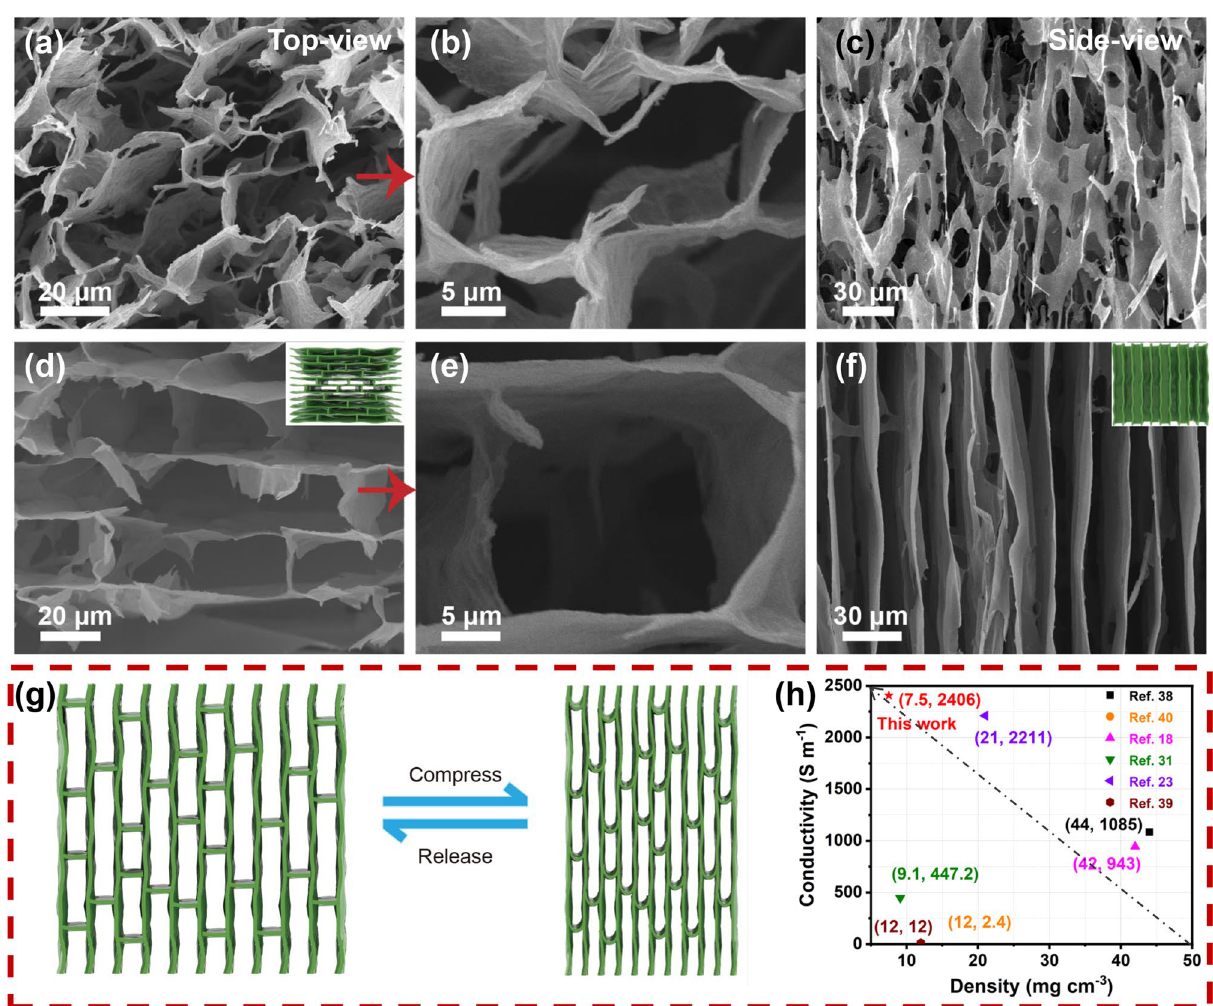
Fig. 2 a , b The top-view and c side-view SEM images of CNT/MXene (1:7) aerogel. d , e The top-view and f side-view SEM images of CNF/ CNT/MXene (2:1:7) aerogel, the inset is schematic diagram of the pore structure. g Schematic illustration of compression and release process for CNF/CNT/MXene aerogel (2:1:7). h Comparison of the conductivity with other MXene-based Figure 2a–f show the SEM images of CNT/MXene (1:7) and CNF/CNT/MXene (2:1:7) aerogels. The CNT/MXene (1:7) aerogel without CNF component exhibits a loosely